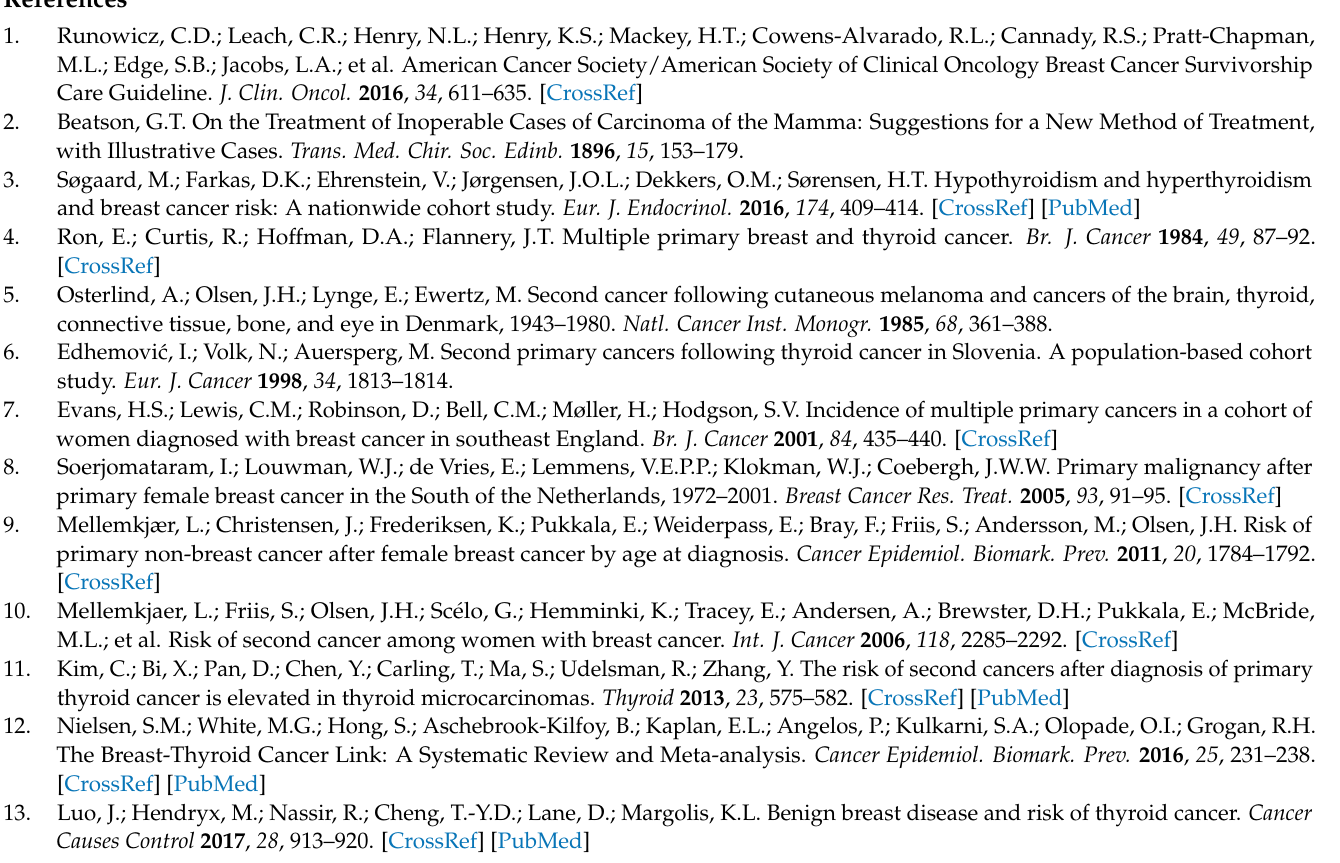
of thyroid cancer after breast cancer; Table S2: Standardized incidence ratios of breast cancer after thyroid cancer; Table S3: Level of evidence about Thyroid cancer and Breast cancer; Table S4: Level of evidence about Thyroid Hormone and Breast cancer; Table S5: Level of evidence about Estrogen and Thyroid cancer; Table S6: Level of evidence about Autoimmune thyroid disease and Breast cancer; Table S7: Level of evidence about Oncogenic effects of the therapies for primary cancer; Table S8: Level of evidence about Genetic predisposition; Table S9: Level of evidence about other factors and Breast cancer. And the level of evidence was classified by standard of OCEBM (Centre for Evidence-Based Medicine, University of Oxford, OCEBM). References [157–193] are cited in the supplementary